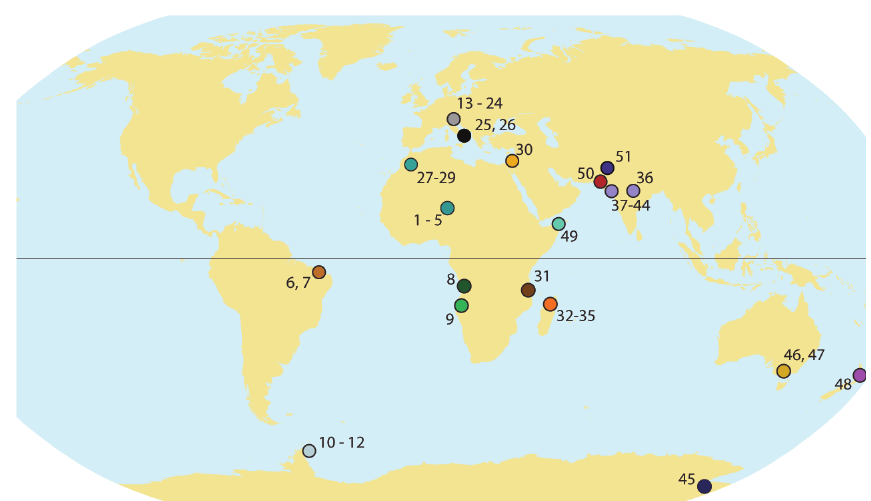
Fig. 1 – Modern distribution of Gondwana dinosaur localities (listed by number in Table I) used in this